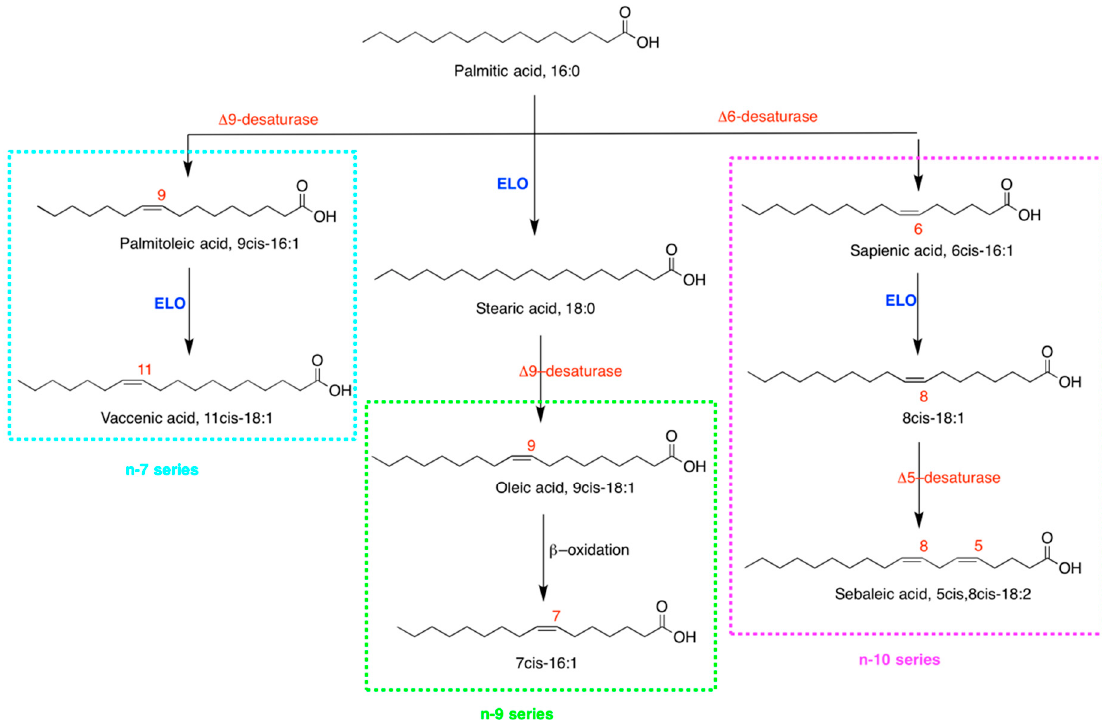
Figure 1. Biosynthetic access to three fatty acid series starting from palmitic acid: ( 1 ) n -7 series (blue box) formed via a first direct desaturation step to palmitoleic acid (9 cis -16:1) by delta-9 desaturase (stearoyl-CoA desaturase, SCD1) creating a double bond in C9–C10 position, followed by elongation to vaccenic acid (11 cis -18:1); ( 2 ) n -9 series (green box) with oleic acid (9 cis -18:1) formed in two steps, including elongase enzymatic activity from palmitic to stearic acid (18:0) and subsequent desaturation creating the double bond in C9–C10 of the 18 carbon atom fatty acid chain; the beta oxidation step from oleic acid also brings to another monounsaturated fatty acid (MUFA) of the n -9 series, i.e., 7 cis -16:1; ( 3 ) n -10 series (purple box) with the formation of sapienic acid (6 cis -16:1) by delta-6 desaturase activity on palmitic acid followed by the elongation step to 8 cis -18:1. The subsequent fate of 8 cis -C18:1 is the transformation into a n -10 polyunsaturated fatty acid, 5 cis ,8 cis -18:2 (sebaleic acid) via delta-5 desaturase enzyme.